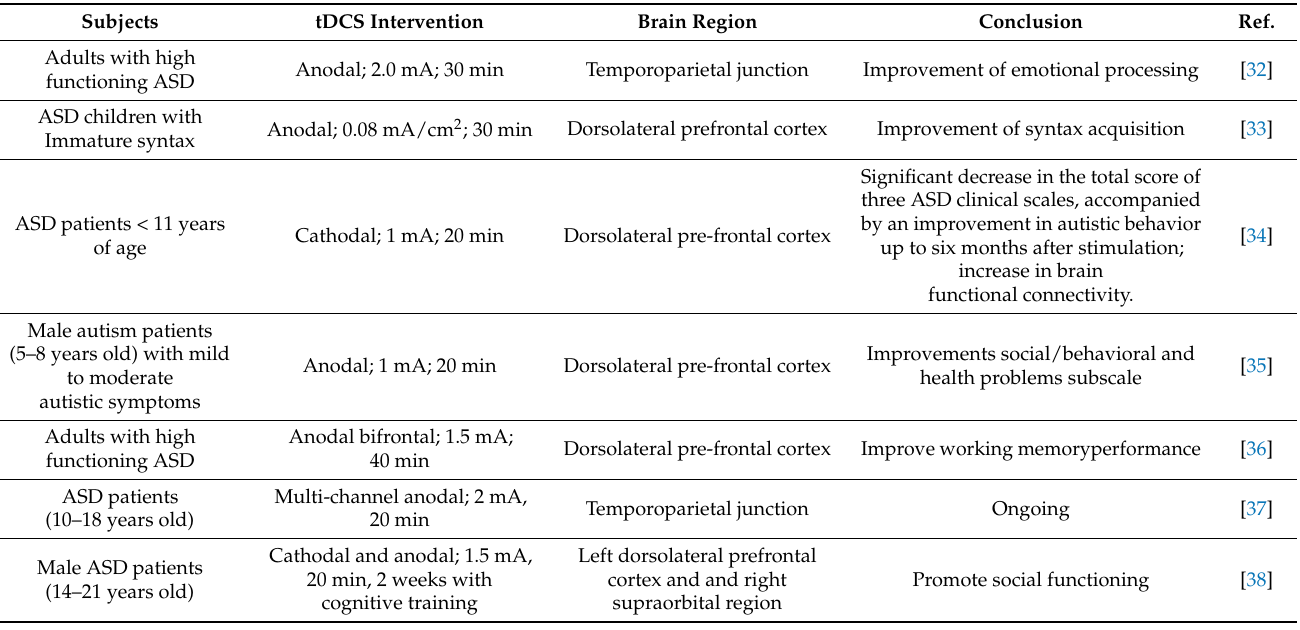
Table 1. Summary of studies on the effects of tDCS on Autism Spectrum Disorder